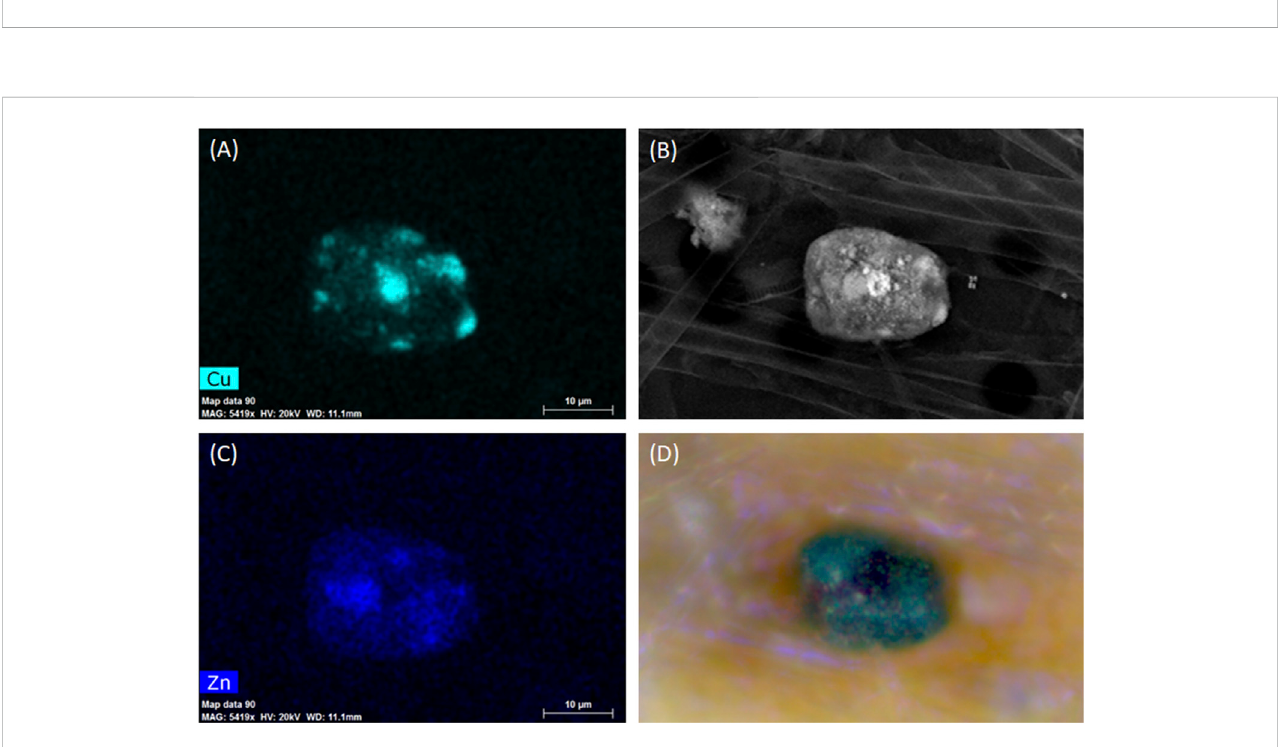
FIGURE 7 A blue particle, as determined by LM (D) with high zinc and copper content, measured with SEM-EDX (B) and shown in elemental maps (A,C) , is an example of the correlative microscopy approach using fi rst SEM-EDX with elemental mapping for elemental content and LM for color identi fi cation.